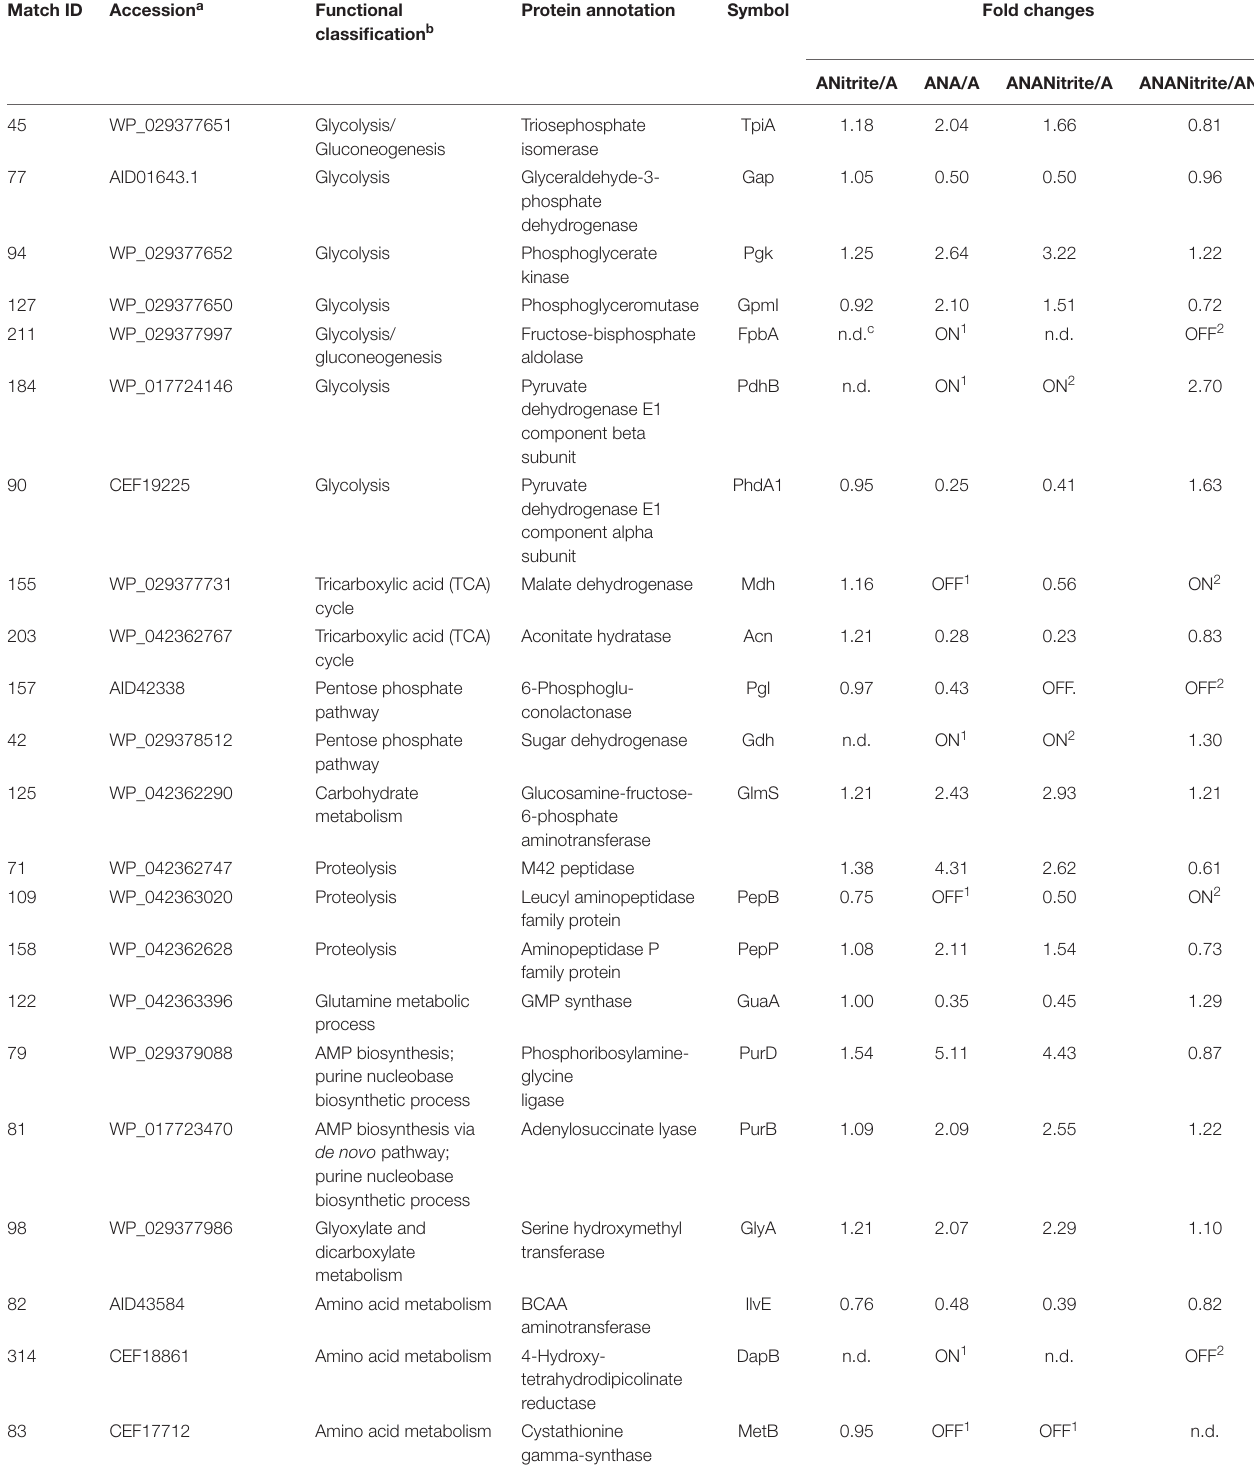
TABLE 2 | Fold changes of Staphylococcus xylosus DSM 20266T proteins synthesized under the different experimental conditions (ANitrite/A, aerobiosis with nitrite/aerobiosis; ANA/A, anaerobiosis/aerobiosis; ANANitrite/A, anaerobiosis with nitrite/aerobiosis; ANAnitrite/ANA, anaerobiosis with nitrite/anaerobiosis; ≥ 2-fold, P <